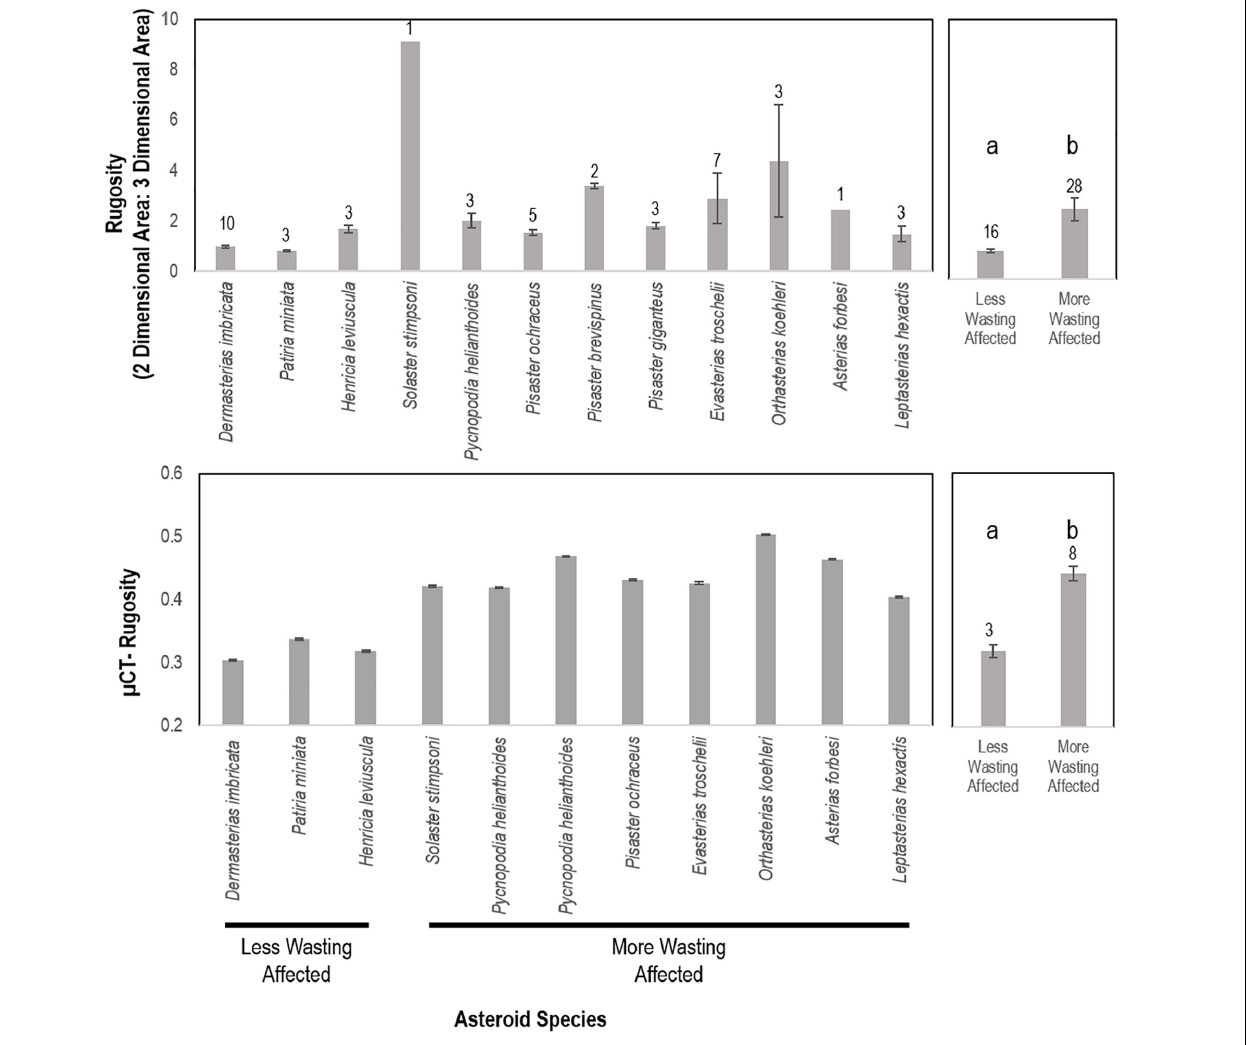
FIGURE 9 | Rugosity of similarly sized specimens between wasting-affected and less wasting affected species as determined by whole animal computed tomography (top) and of an asteroid ray by micro-computed tomography (bottom). a,b denote significant difference at p < 0.001. More and less wasting affected assignment were based upon previous work and defined in the